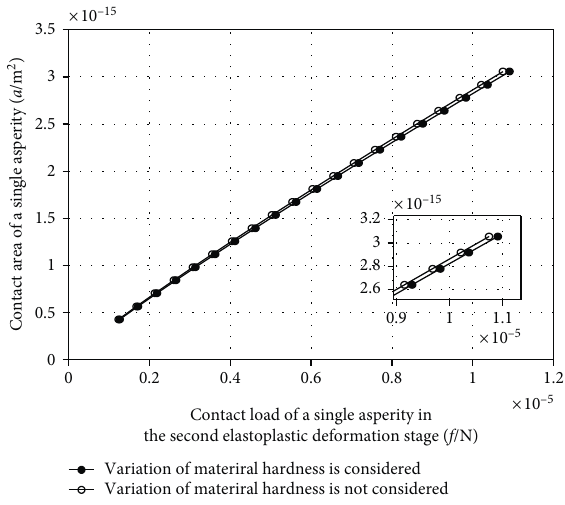
Figure 10: The contact load-contact area relationship of a single asperity in the second elastoplastic deformation stage ( n � 38, A A � 0 . r / a